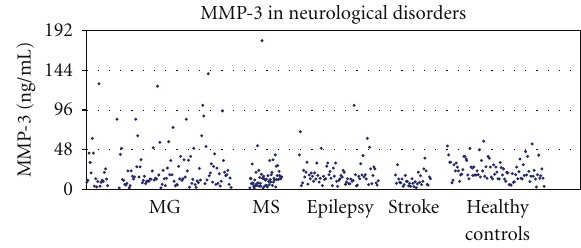
Figure 1: Scatter plot of the MMP-3 concentrations in patients with neurological disorders and healthy controls. The 2 SD cut-o ff at 48ng/mL is